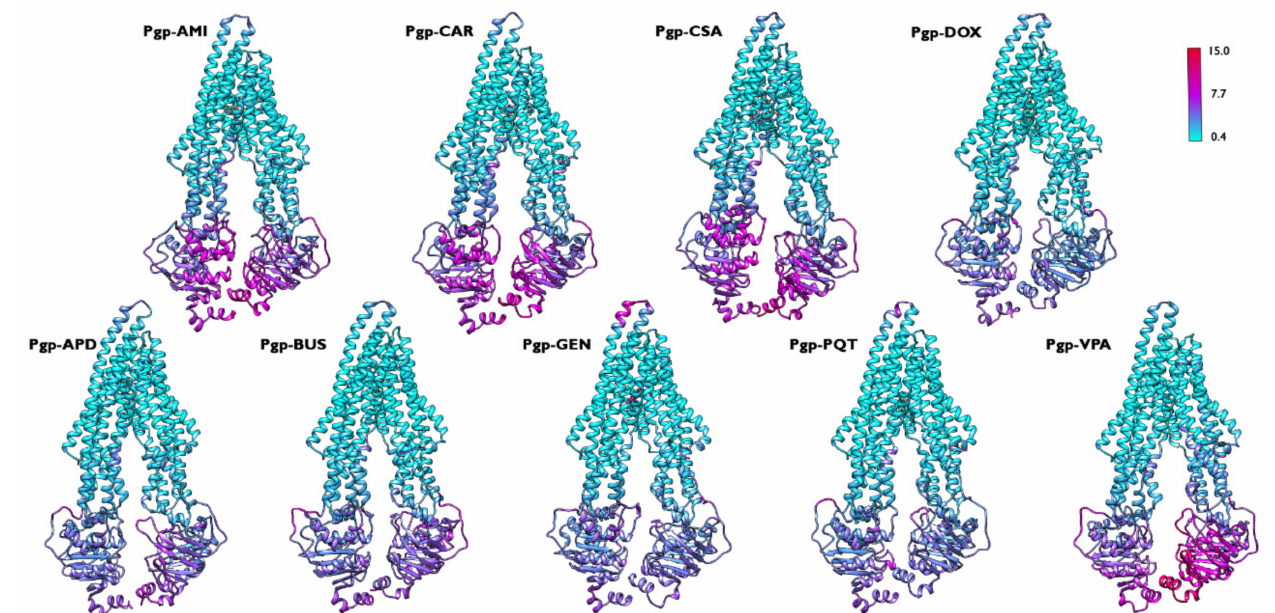
Figure 4. Backbone RMSF coloured representation for the simulated P-gp–ligand systems along the 500 ns production run. The flexibility scale goes from cyan (lower values) to red (higher values). The same regions are among the most flexible in all of the studied systems; however, the flexibility is higher for the active